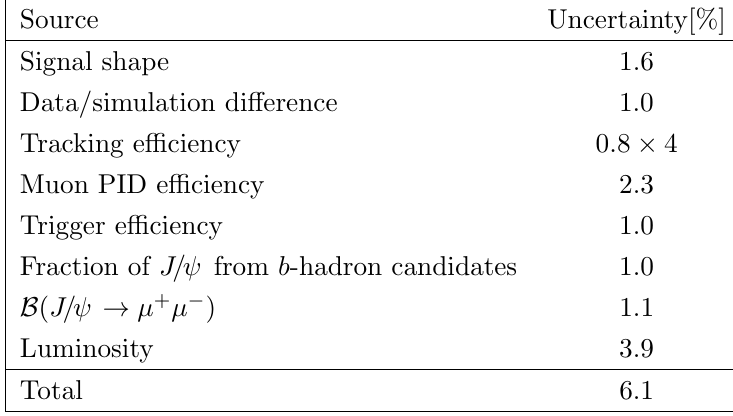
Table 1. Summary of the systematic uncertainties on the measurement of the J= pair production cross-section.